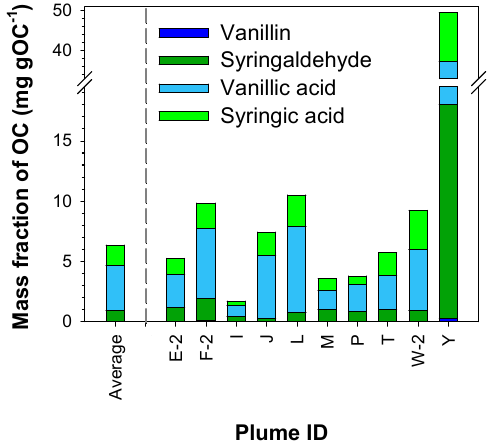
Figure 6. Organic carbon mass fraction of measured lignin decom- position products for study average and selected individual plumes. Plume Y was not included in average calculation as discussed in Sect.